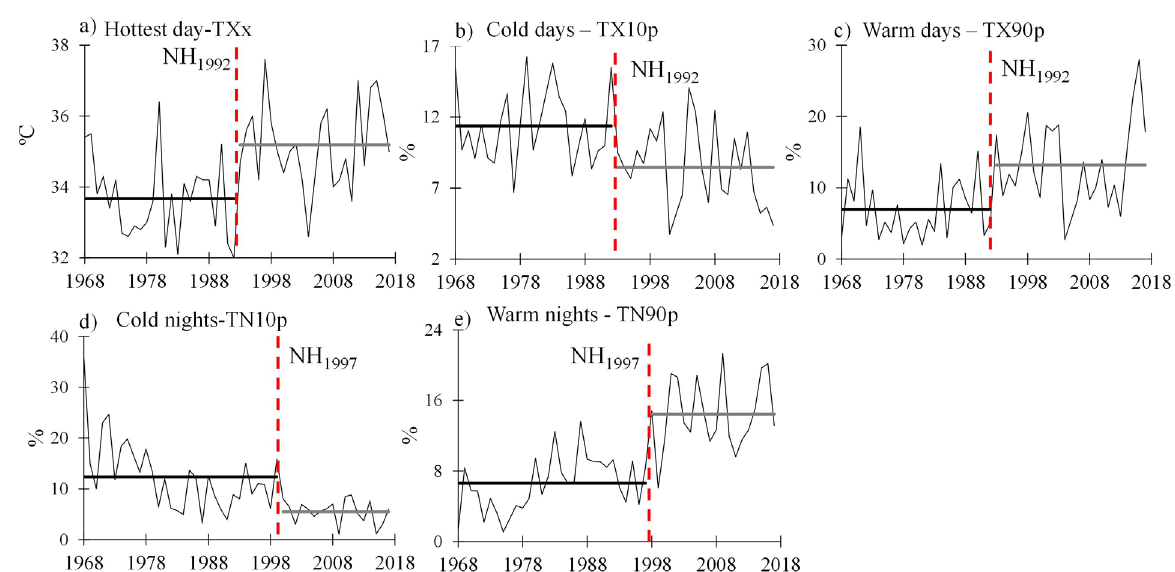
Figure 5. Temporal distribution of the extreme temperatures indices that presented abrupt changes points during 1968–2017 for the annual scale. Dashed red line indicates a nonhomogeneous series and the respective year of rupture